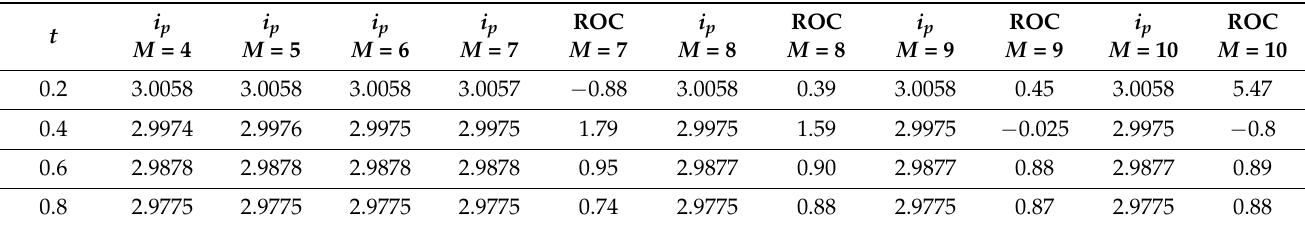
Table 4. The values of i p and rate of convergence (ROC) at different points for k = 2 and various values of M by Bernoulli wavelets.